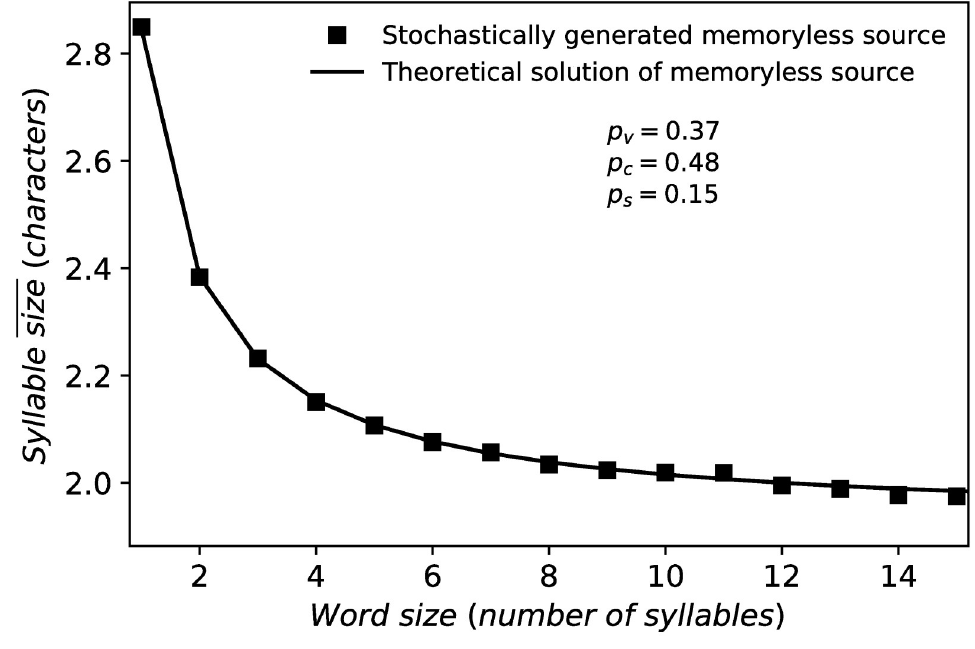
Fig 2. Menzerath-Altmann’s law for the memoryless source. Parameter p The solid line is the theoretical model, given by Eqs (4) and (5), whereas the square points are the simulation of the memoryless